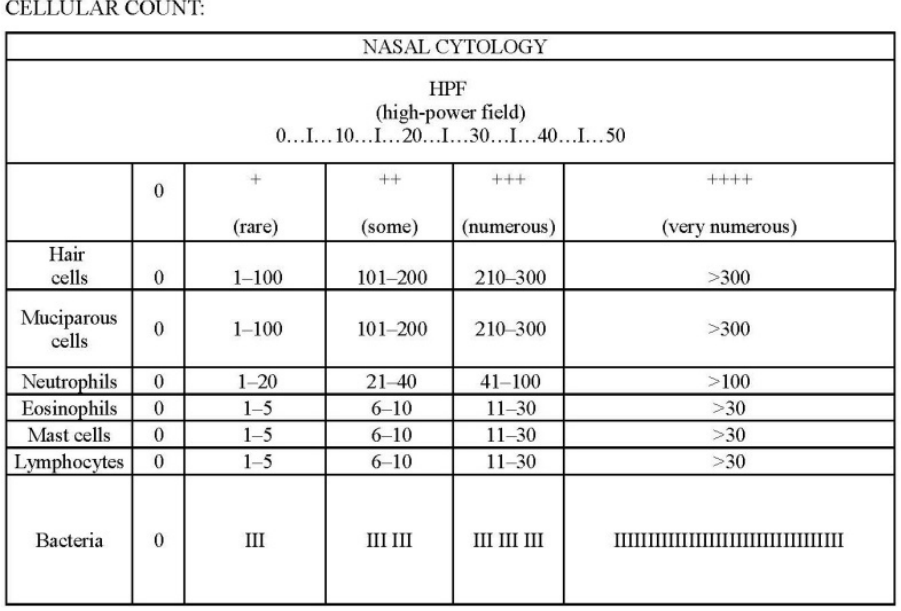
Figure 1. Rhinocytogram. Figure 1.